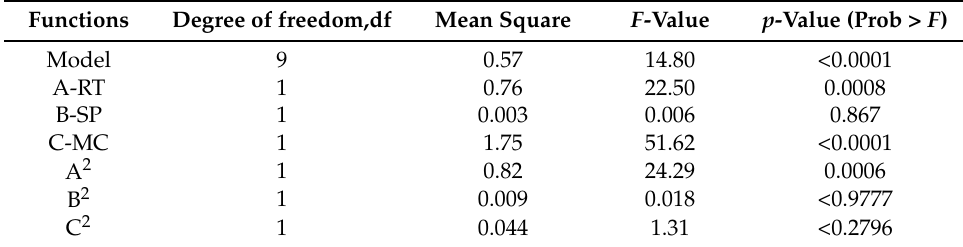
Table 5. Statistical parameters for developed model and process parameters. Functions Degree of freedom,df Mean